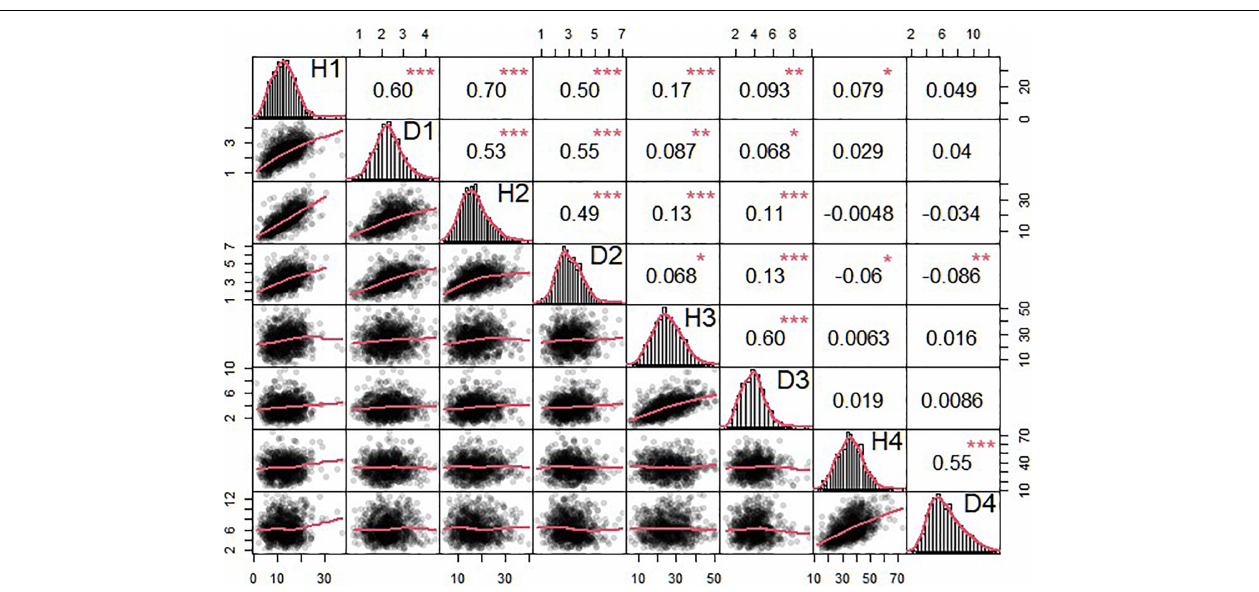
FIGURE 3 | Phenotypic data analysis of seedling height and diameter in T. grandis. The triangle in the upper part of the figure is the correlation and significance and that in the lower part of the figure is scatterplot and its fitting curve. The diagonal part is normal distribution of seedling height and diameter data. 1, 2, 3, and 4 in the diagonal part means the year 2018, 2019, 2020, and 2021. * p < 0.05, ** p < 0.01, *** p < 0.001.